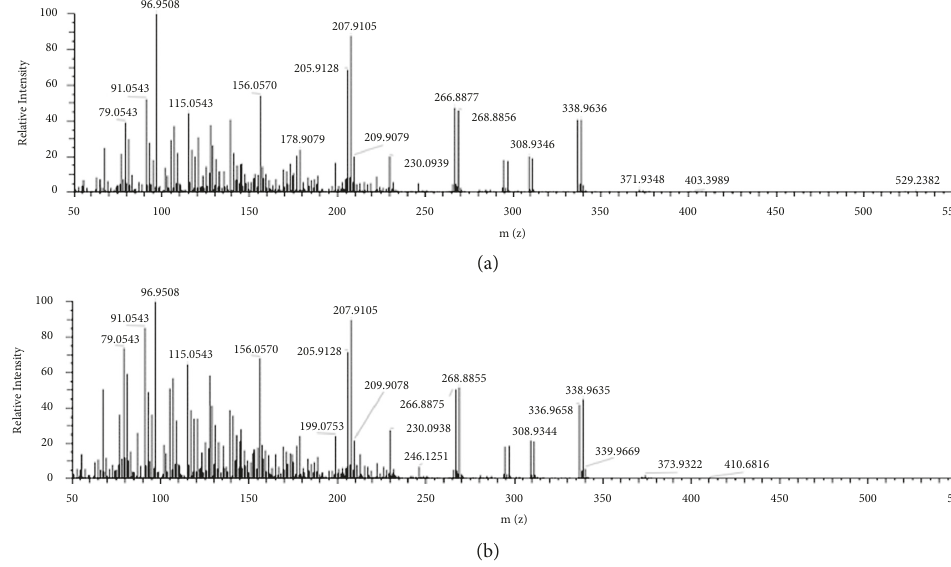
Figure 4: Mass spectrum of profenofos in the standard (a) and chrysanthemum flower positive samples